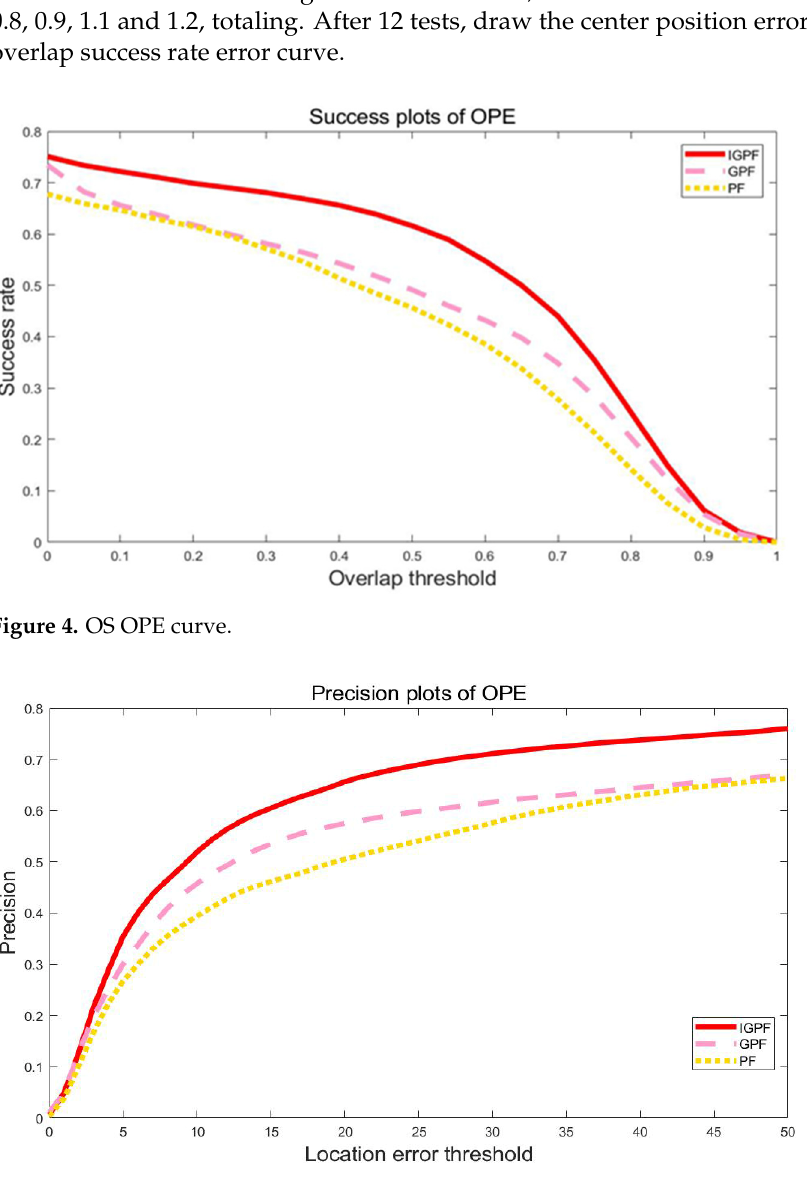
Figure 6. OS TRE curve.